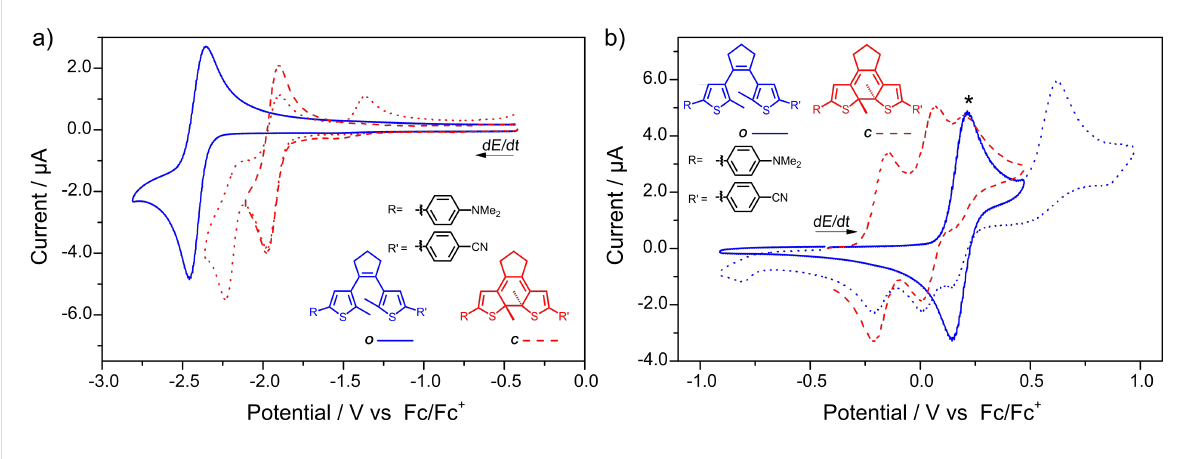
Figure 6: Cyclic voltammograms of Me 2 NPh-DTE-PhCN displaying separated one-electron anodic and cathodic waves. a) Reversible first one-elec- tron reduction (blue line) of O- Me 2 NPh-DTE-PhCN . The second reduction potential cannot be accessed. First (red dashed line) and second one-elec- tron reduction (red dotted line) of C- Me 2 NPh-DTE-PhCN are shown for comparison. b) Oxidative cyclization of O- Me 2 NPh-DTE-PhCN occurs only at the second oxidation/reduction step (blue dotted line), whereas the first step (blue line) is reversible. The oxidation waves of the closed isomer (red dashed line) are shown for comparison. The asterisk marks the oxidation wave of residual open isomer after irradiation. Experiments in MeCN with 0.1 M Bu 4 NPF 6 , c = 1 ∙ 10 − 3 M, dE / dt = 1 V s − 1 .